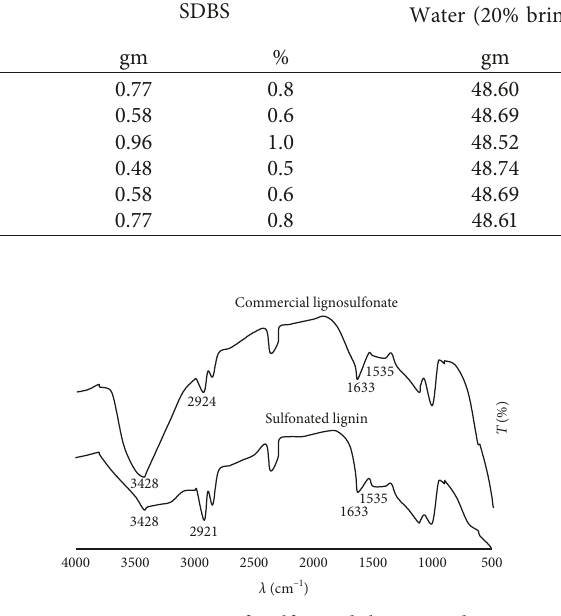
Figure 2: FTIR spectra of sulfonated lignin and commercial lignosulfonate.